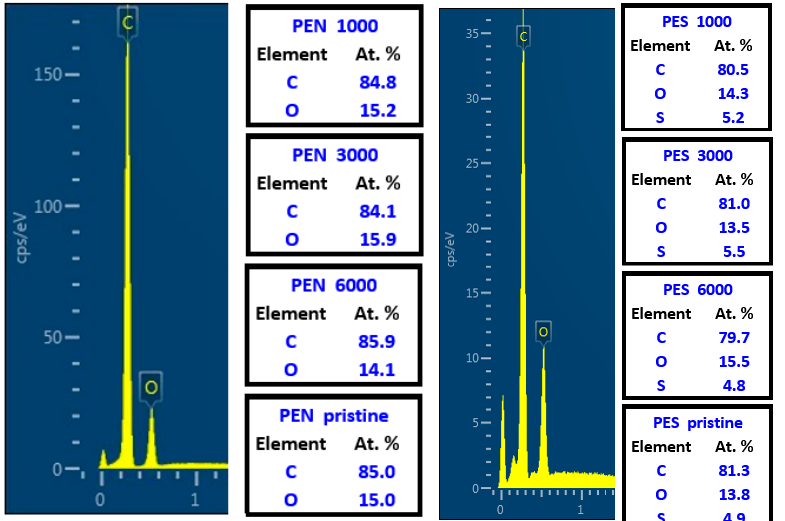
Figure 2. Spectra from energy-dispersive X-ray spectroscopy (EDX) analysis and elemental atomic concentrations (carbon, oxygen, sulfur) for PEN and PES samples treated by KrF laser with the laser fluence of 10 mJ·cm − 2 and 1000, 3000, and 6000 pulses.